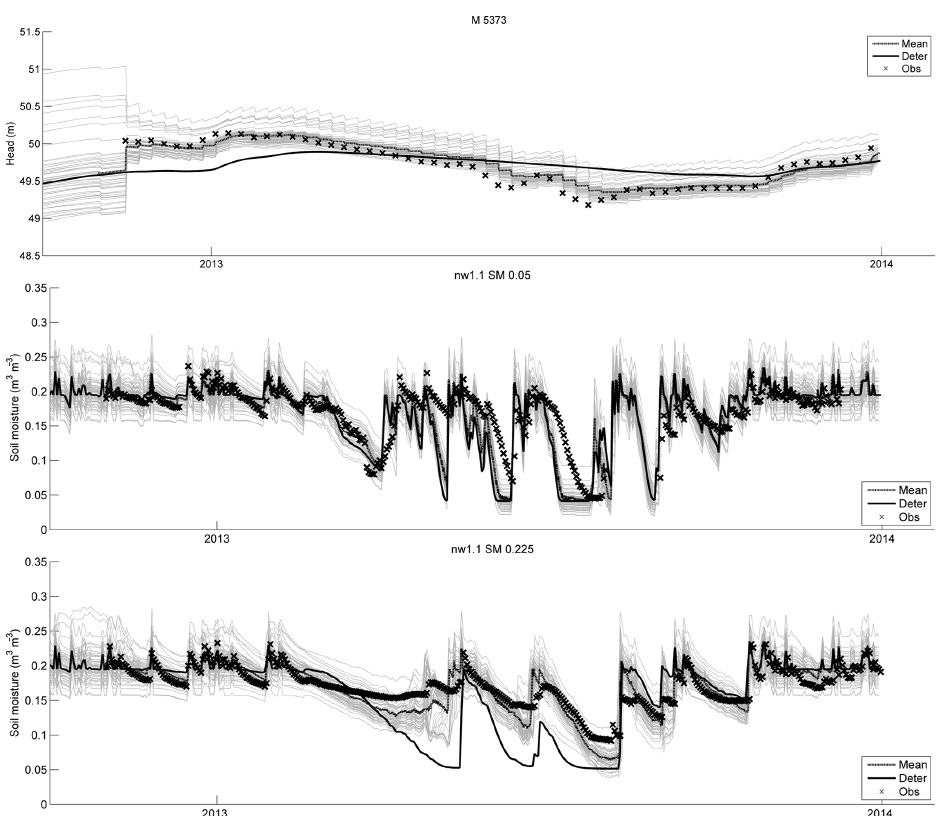
Figure 8. Top: groundwater head at well M5373. Middle: soil moisture at 2.5cm at site nw1.1. Bottom: soil moisture at 22.5cm depth at site nw1.1. The light grey lines (not in the legend) are ensemble predictions. “Mean” (single grey line) is the ensemble average. “Deter” (dark line) is the deterministic model. “Obs” (cross marks) are the observations. Note that the assimilation starts from 1 November